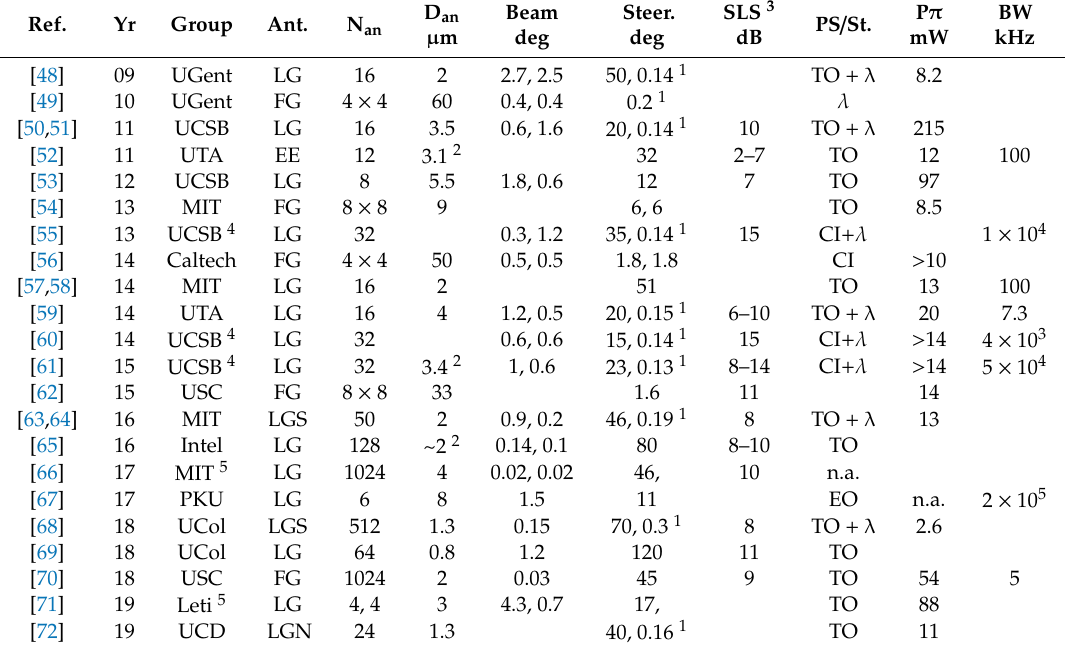
Table 5. A comparison of selected published integrated photonics OPA research work.